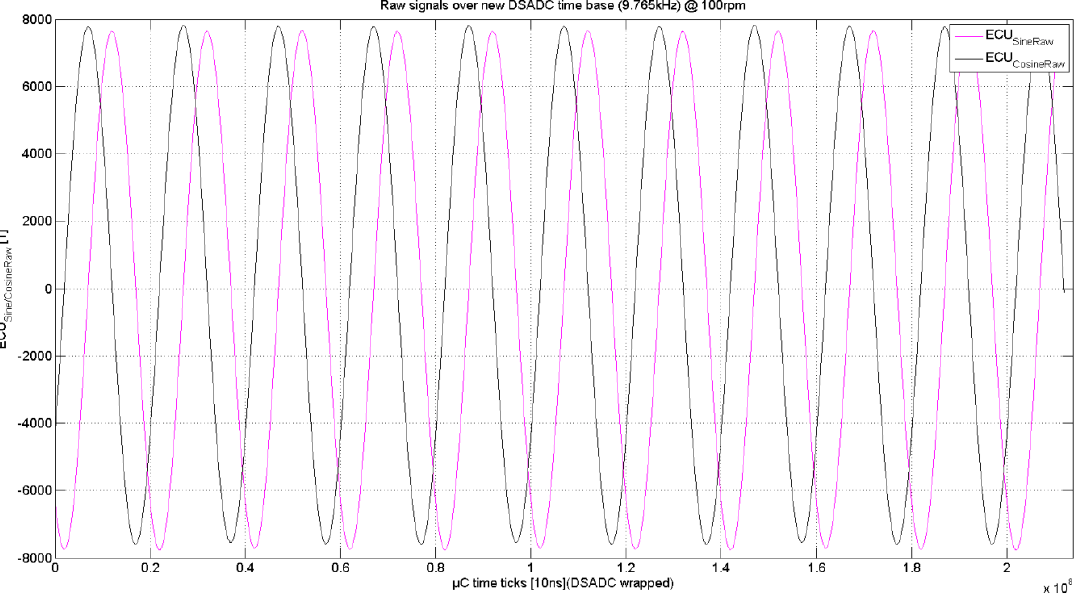
Figure 17. Raw resolver signals, sampled by the DSADC of the ECU. The upper plot (magenta curve) shows the channel 1 of the DSADC: the raw, demodulated sine signal with a sampling frequency of f s = 9.765 kHz. The lower plot (black curve) shows the result of the channel 2 of the DSADC: the raw, demodulated cosine signal with the same sampling frequency f s = 9.765 kHz. It has to be stated that the time base for both signals is the continuous DSADC time base with the removed wrap ‐ around (see example Figure 14) in the μ C basic unit time ticks (10 ns).